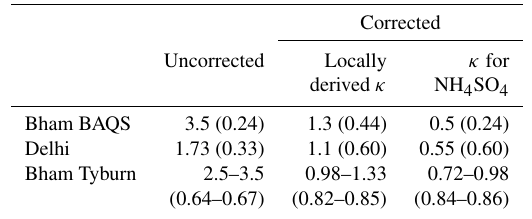
Table 3. Slopes of uncorrected and corrected PM 2 . 5 mass concen- trations from the OPC-N2 relative to the reference instruments ( r 2 in parentheses). Intercepts were not constrained to zero. There were four OPC-N2 sensors measuring at Bham Tyburn, and the range of measurements from these instruments is presented.